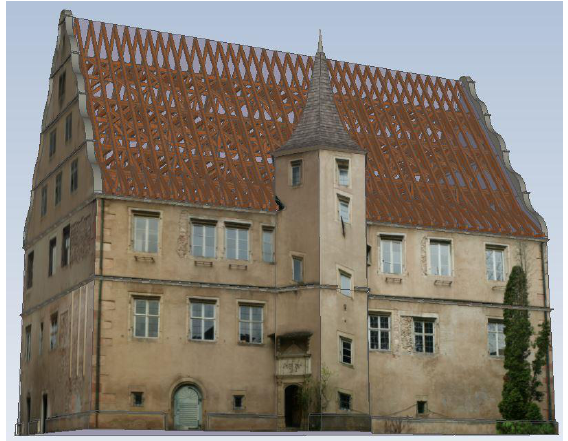
Figure 17: Structured 3D model of the “Seigniory” with accurate model of the wooden